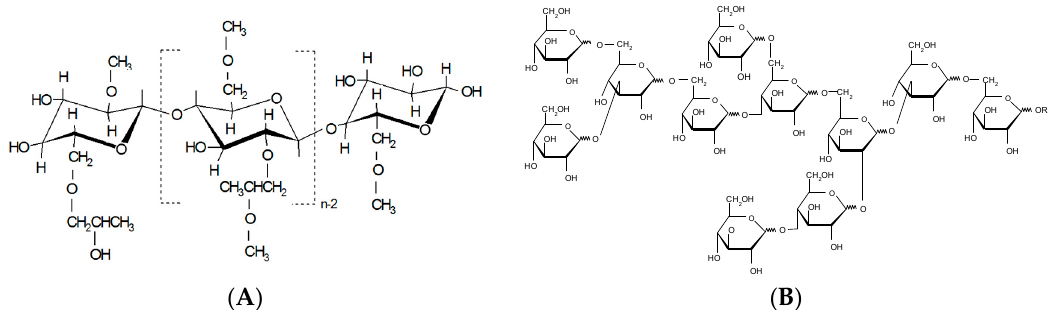
Figure 1. Structural formula of ( A ) hydroxypropyl methylcellulose (HPMC) and ( B ) polydextrose (PD).